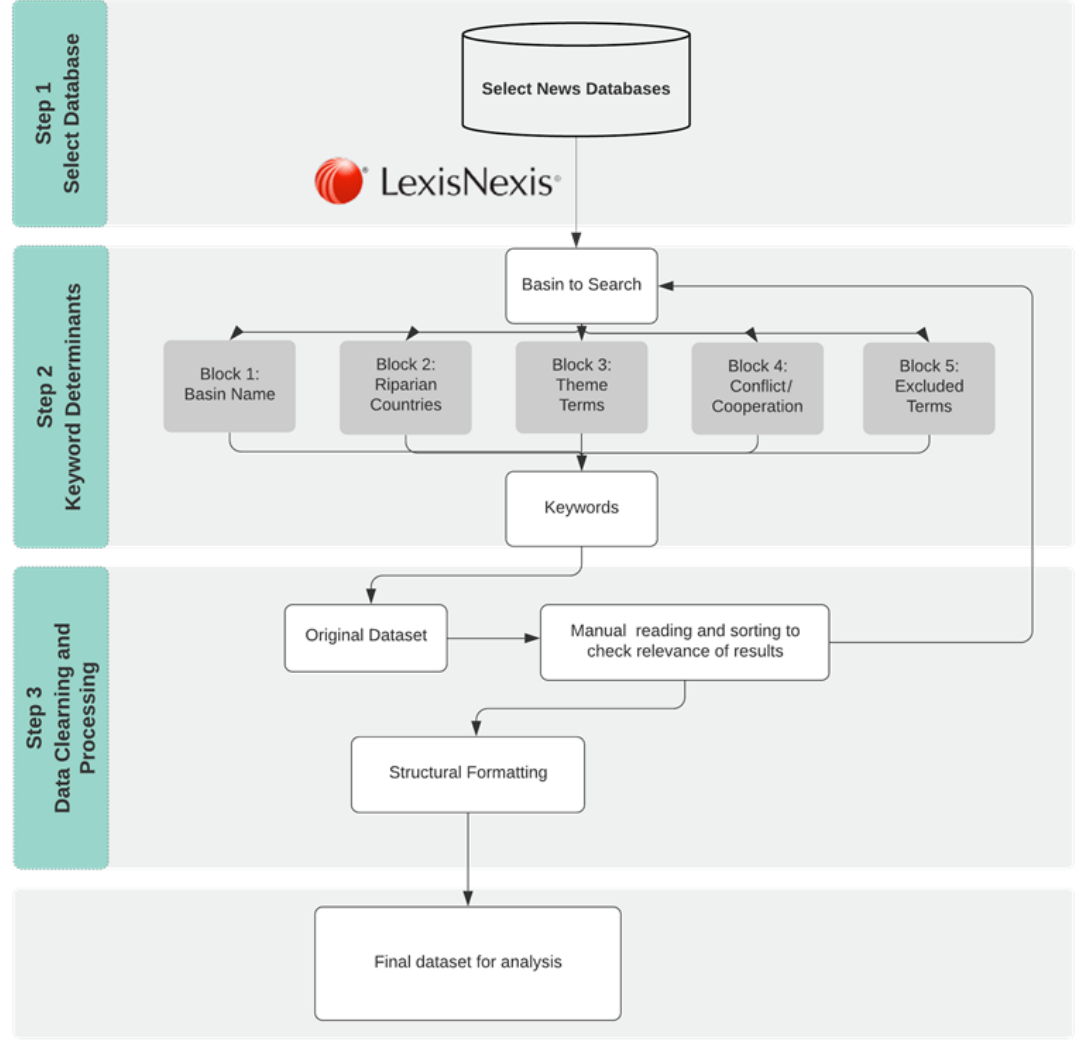
Figure 1. Method flow